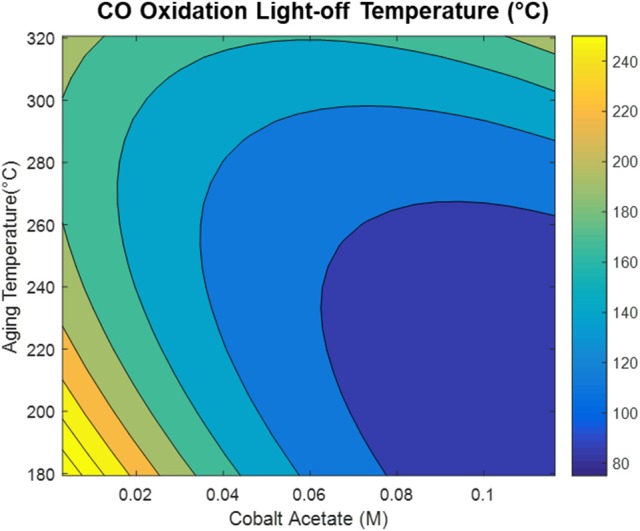
Light-off temperature contour map developed with CCD.